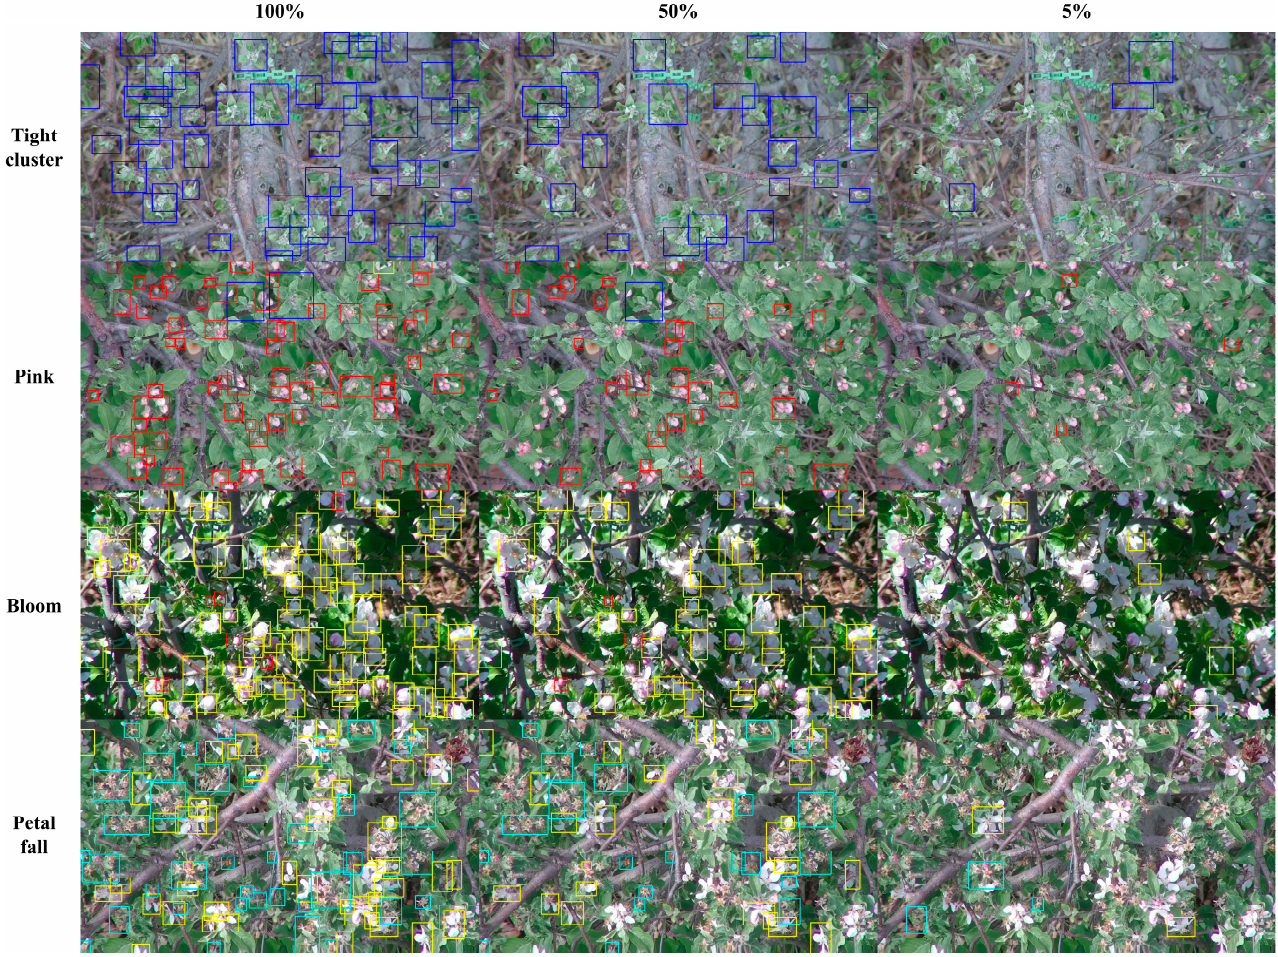
Figure 2. Sample training images containing apple flower buds at four growth stages with different levels of image annotation qualities.